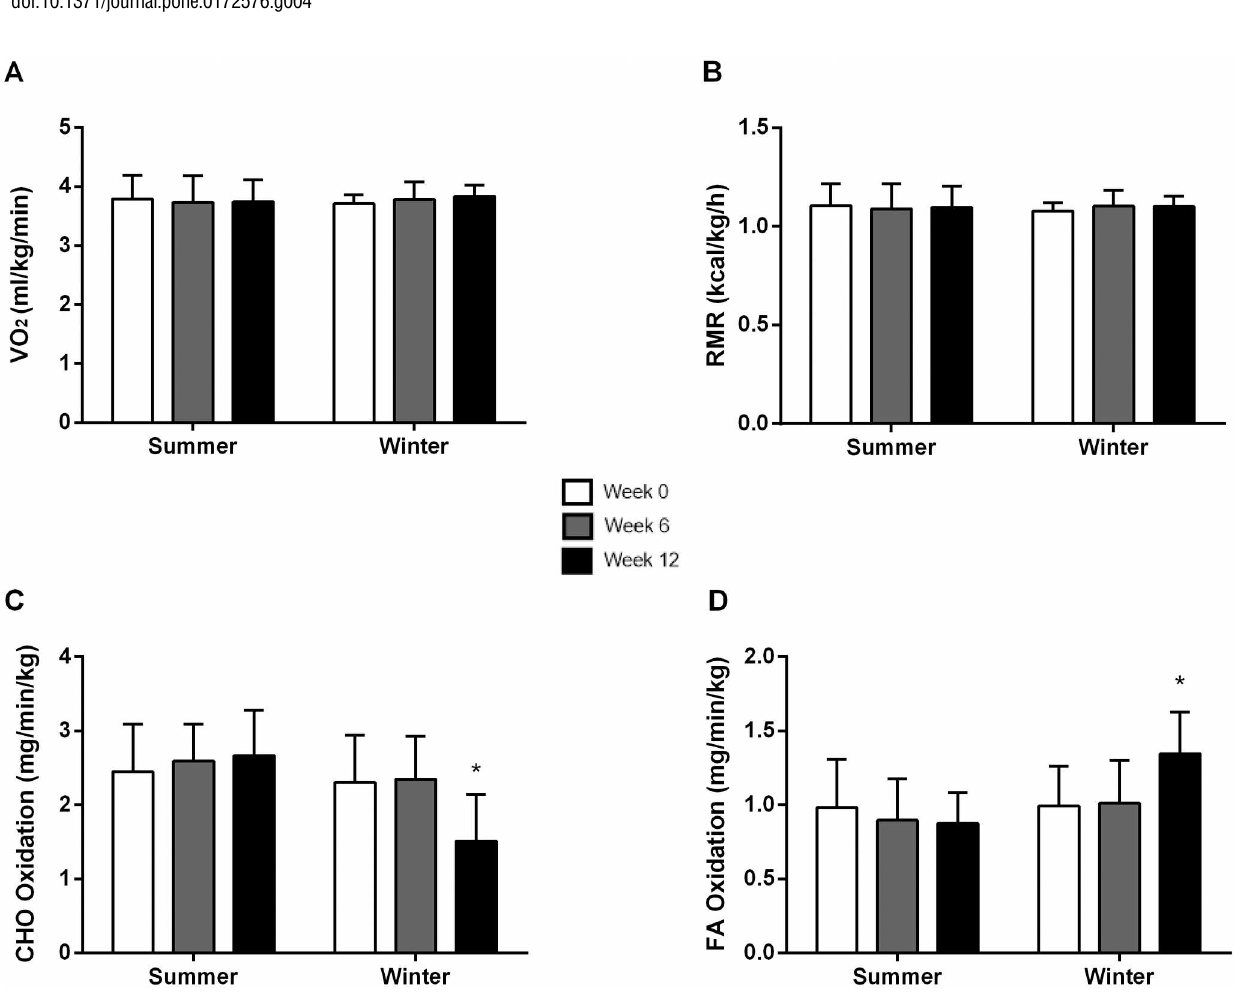
Fig 5. Resting oxygen consumption (VO2) (A), resting metabolic rate (RMR) (B), carbohydrate (CHO) oxidation (C), and fatty acid (FA) oxidation (D) normalized to body mass at weeks 0, 6 and 12 in summer and winter groups. Values are reportedas means ± SD. * Significantlydifferent from weeks 0 and 6 (Winter) and weeks 0, 6 and 12 (Summer) (p < 0.01). doi:10.1371/journal.pone.0172576.g005 PLOS ONE | DOI:10.1371/journal.pone.0172576 February 17,